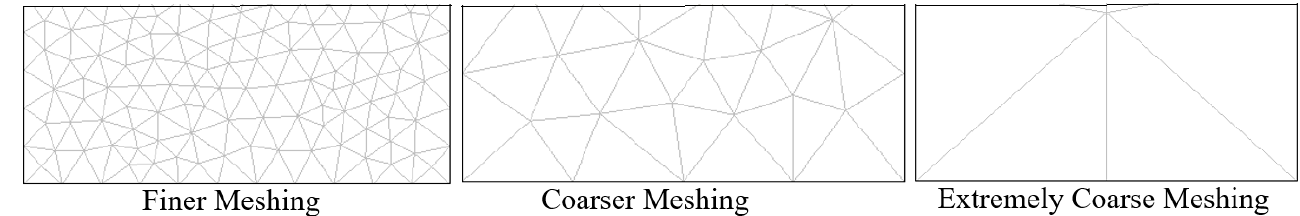
Figure 10. Different meshing qualities.